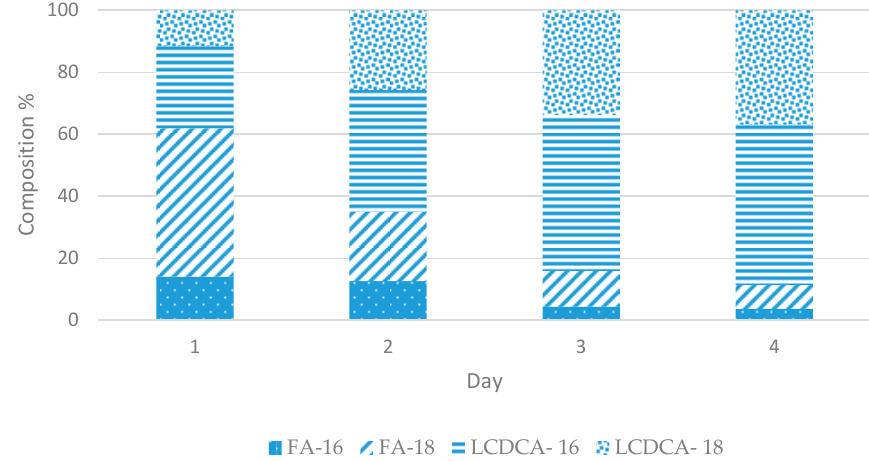
Figure 7. Percentage composition of fatty acids and LCDCAs produced by the ML strain/treatment. Glycerol based media under nitrogen-limiting conditions (C/N = 50). ML: ∆ POX1 -6 ∆ LEU2 ∆ SNF1 16 carbons, FA-18: fatty acid of 18 carbons, LCDCA-16: long chain dicarboxylic acids of 16 carbons, LCDCA-18: long chain dicarboxylic acids of 18 carbons. Data from 2 rounds of batch fermentation. Table 4. Summary of the production level for biomass, citric acid, and LCDCAs. DCW